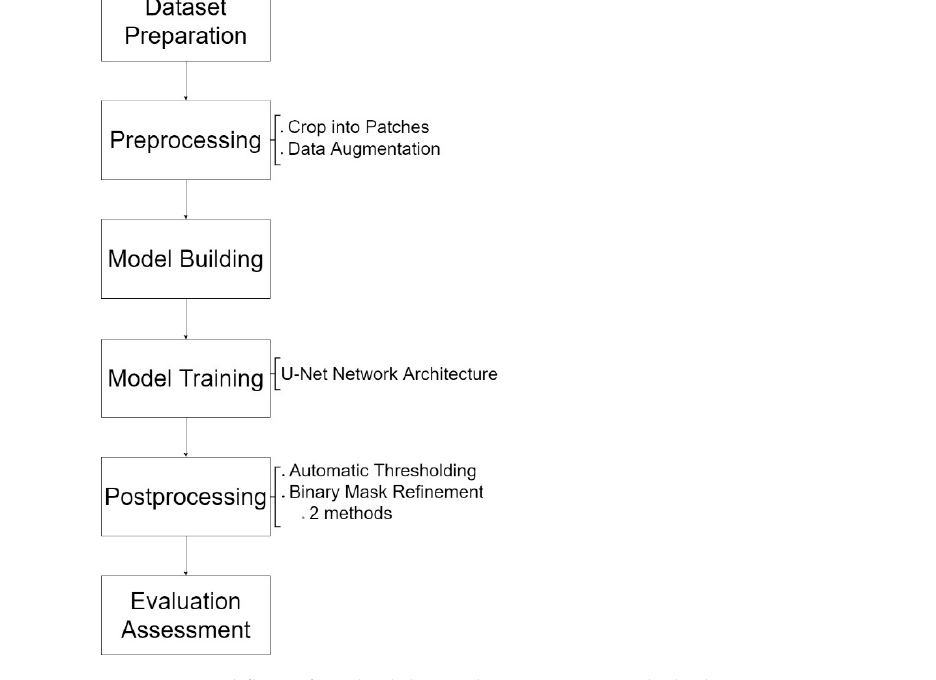
Figure 1. Workflow of methodology. The main steps include dataset preparation, image preprocessing, building of the shadow model, model training, post-processing, and evaluation of results.